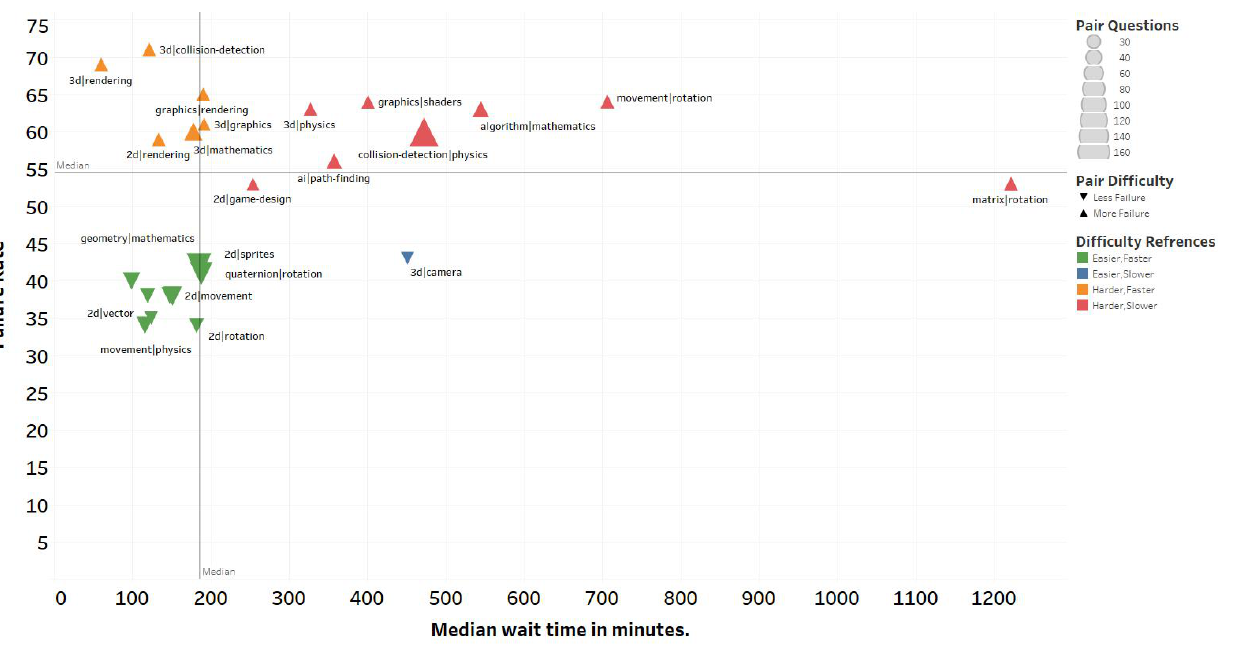
Figure 9. Community support for concept–concept pairs. Upwards (resp. downwards) triangles indicate cases where the pair has a failure rate at least 5 points higher (resp. lower) than any of its constituents. The size of the triangles is indicative of the number of questions for the tag pair. Colours indicate the relative support of the pair in the set of concept–concept